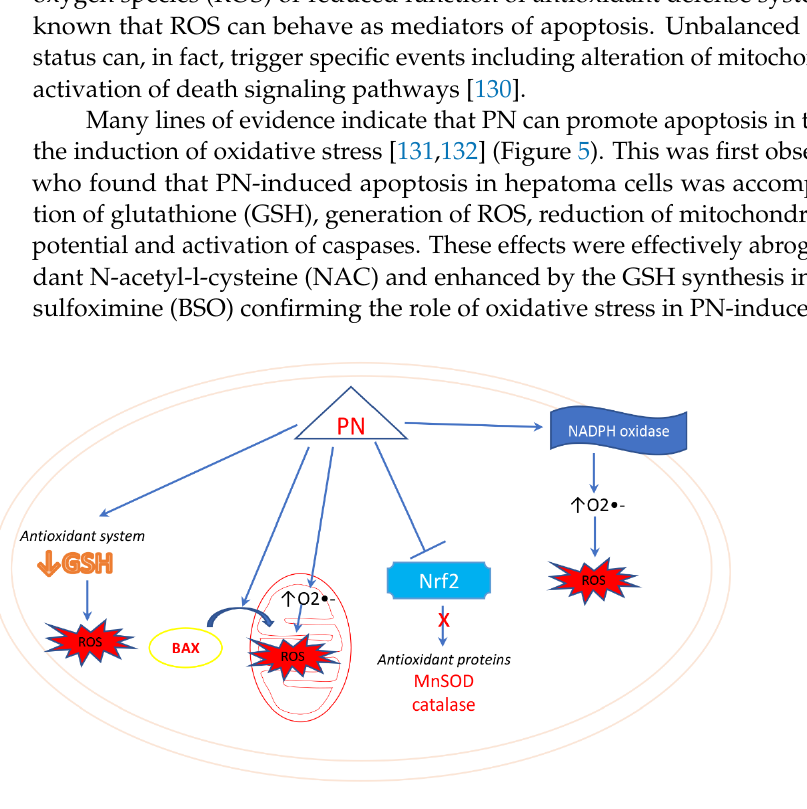
Figure 5. Mechanisms of oxidative stress induction by PN.